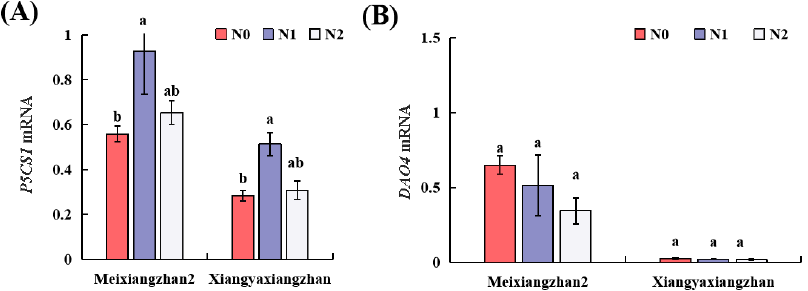
Figure 4. Analysis of transcript levels of ( A ) P5CS1 and ( B ) DAO4 in the grains of both fragrant rice cultivars under N treatments. Data are means ( ± SE), n = 3. The different letter above the column indicates difference at p < 0.05 by LSD tests. Capped bars represent standard